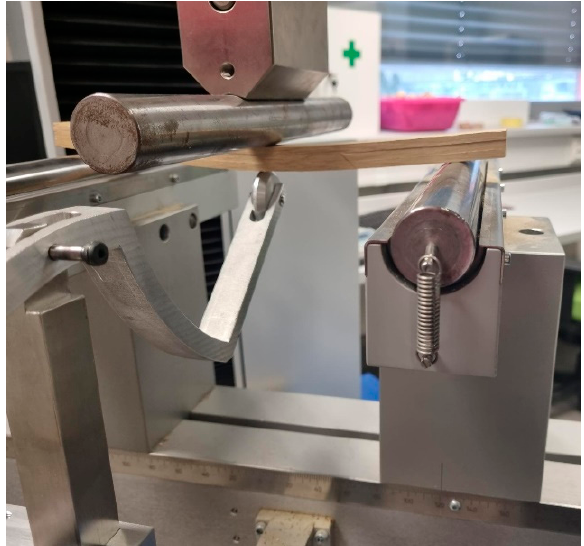
Figure 3. Three-point bending test.